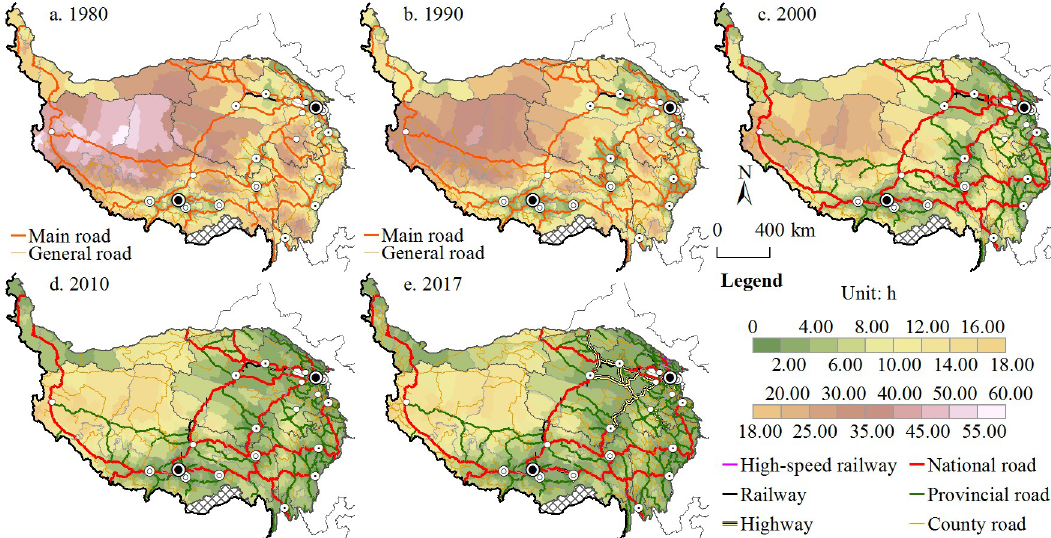
Fig 2. Spatial patterns and changes in time accessibility between townships and major cities from 1980 to